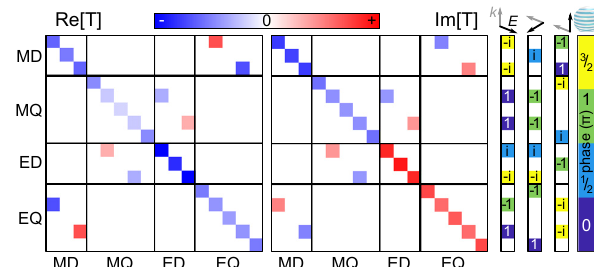
Figure 4: Real and imaginary parts of an exemplary T -matrix of a uniaxial nanosphere (with D ∞ point group) with plotted MD, MQ, h ED, and EQ, and projection of the three unique incident plane waves into these multipoles and their azimuthal